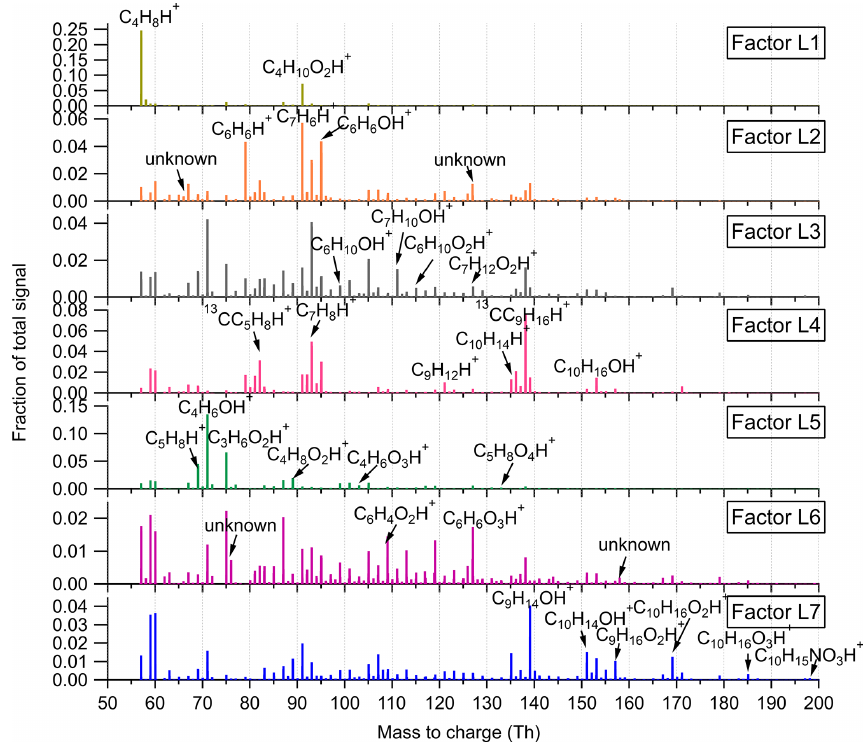
Figure 3. Mass profiles of the seven factors resolved in the low-mass range in the Landes forest. Fingerprint peaks identified by high- resolution peak fitting are shown in the mass